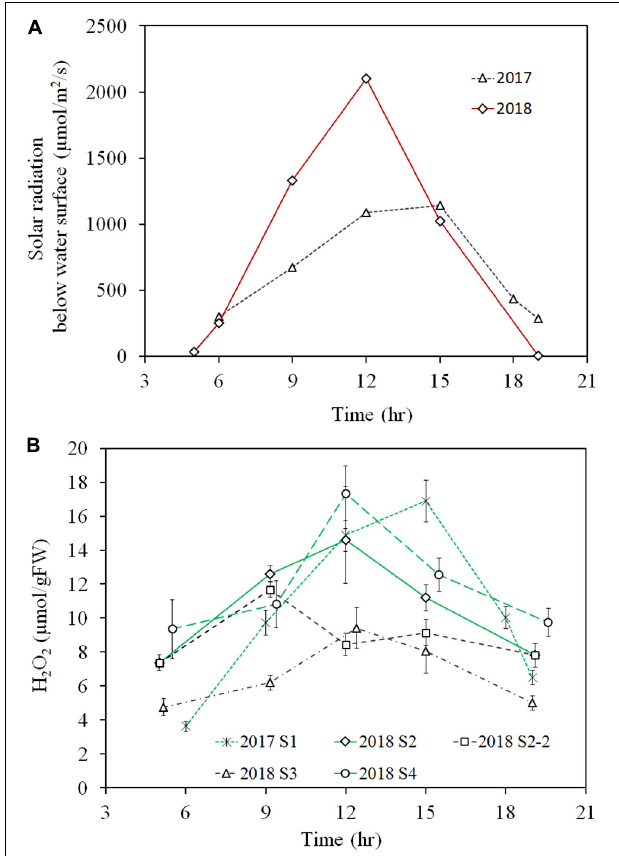
FIGURE 6 | Diurnal variation of light intensity just below the water surface of 2017 and 2018 observations (A) and E . densa tissue H 2 O 2 concentration (B) , observed in the years 2017 (moderate radiation), and 2018 (excessive radiation). 2017 S1 represent the healthy shoots of 2017 observation. 2018 S2-2 and 2018 S3 represent degraded shoots under high solar radiation exposure at shallow water ( < 10 cm deep) in 2018, and 2018 S2 and 2018 S4 represent healthy shoots exposed to moderate radiation in deep depth sites (S2 30 cm deep and S4 50 cm deep) of the observation. The error bars represent the standard deviation.